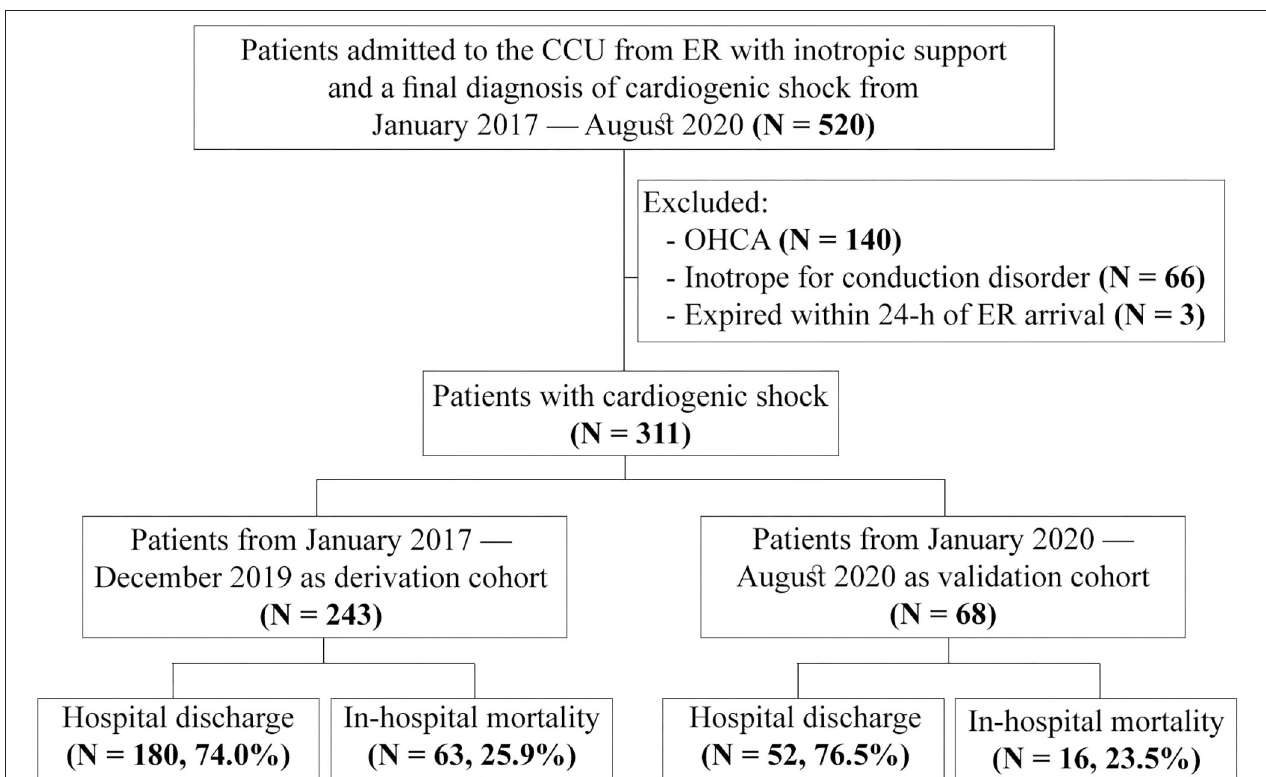
FIGURE 1 | Flowchart of patient enrollment. CCU, cardiac care unit; ER, emergency room; OHCA, out-of-hospital cardiac